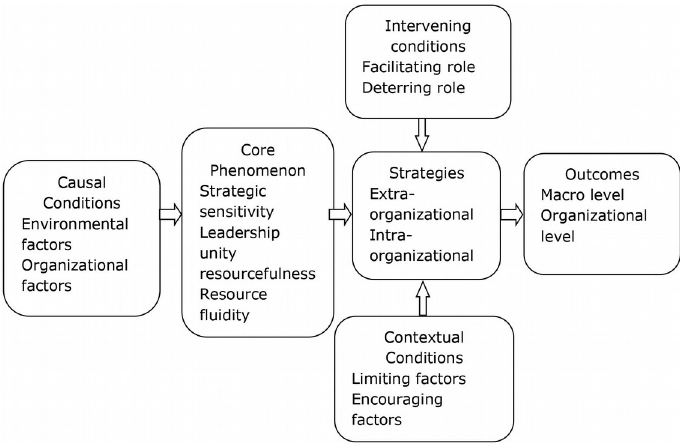
Figure 1. The research